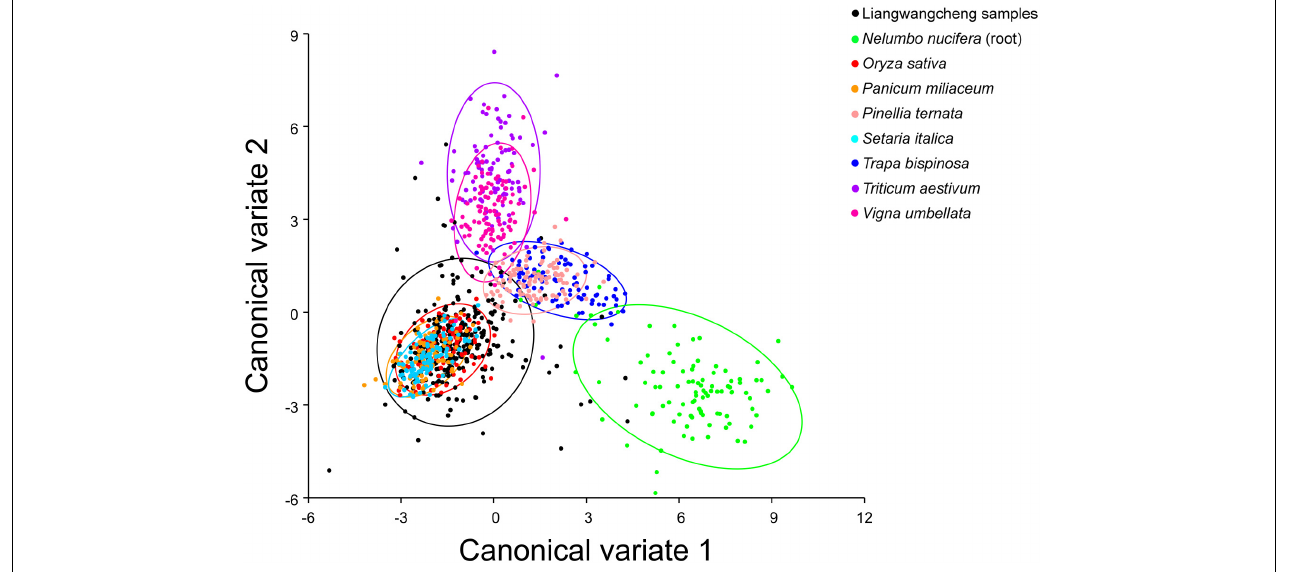
FIGURE 9 | Confidence ellipses (probability = 0.9) based on canonical variate scatter plot of CV1 and